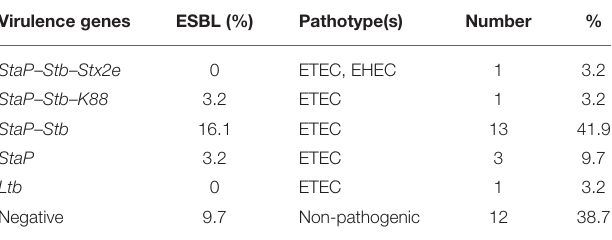
TABLE 3 | Relation analysis between MCRPE resistance to the other six antimicrobial groups and their pathogenicity. Antimicrobial group Pathogenicity Aminoglycosides